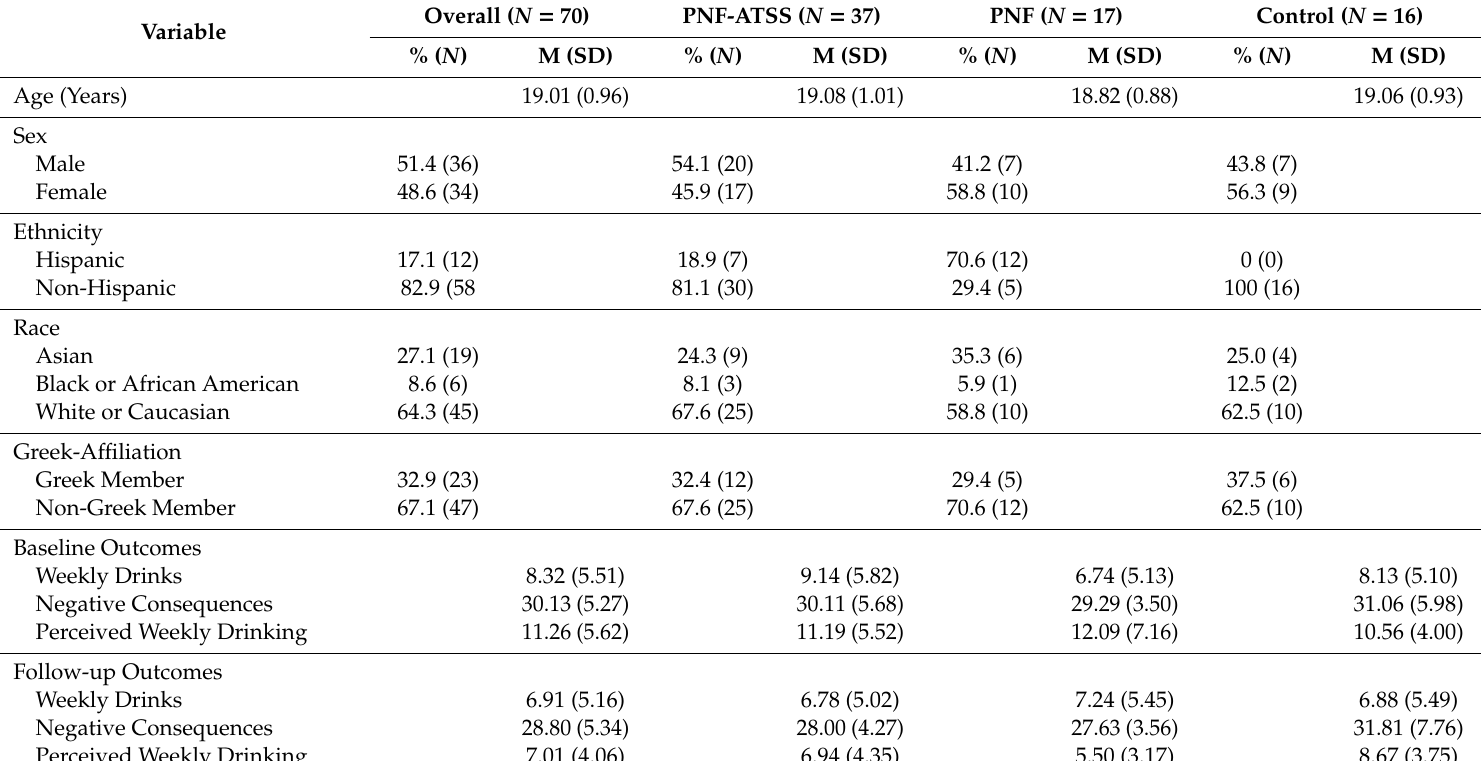
Table 1. Descriptive statistics for demographics characteristics and primary outcomes by study